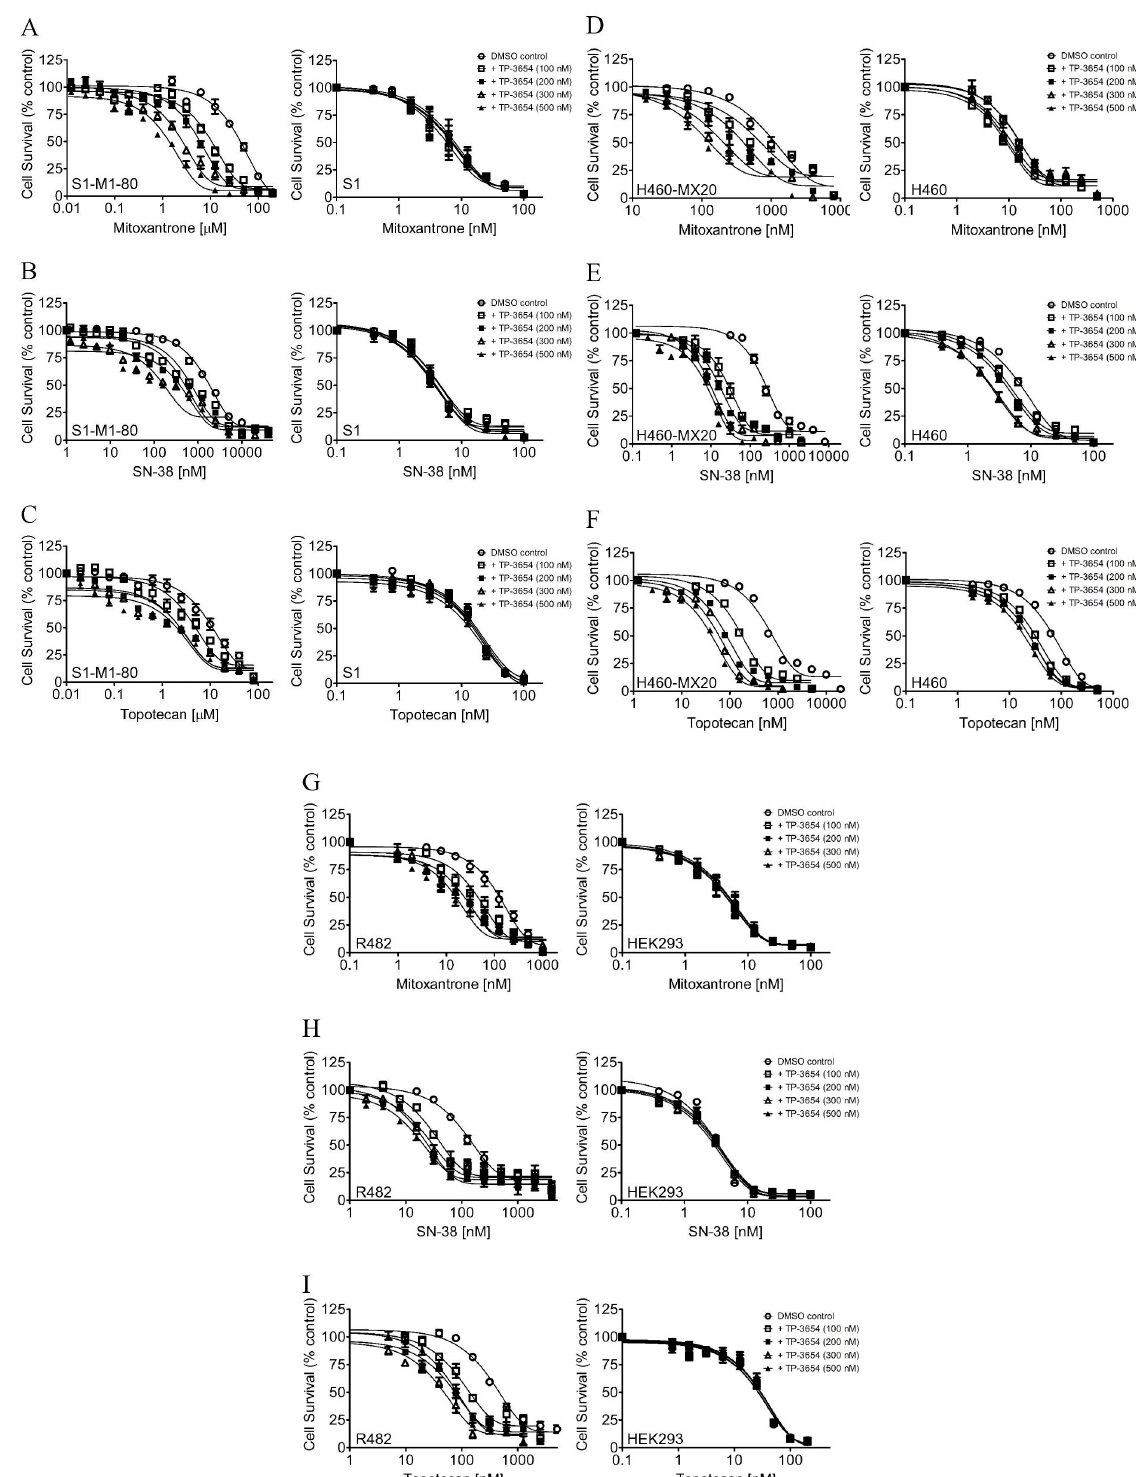
Figure 1. TP-3654 resensitizes ABCG2-overexpressing cancer cells to cytotoxic anticancer drugs. The cytotoxicity of mitoxantrone, SN-38, and topotecan was determined in ABCG2-overexpressing S1-M1-80 ( A – C , left panels) and drug- sensitive parental S1 ( A – C , right panels) cancer cells, ABCG2-overexpressing H460-MX20 ( D – F , left panels), and drug- sensitive H460 ( D – F , right panels) cancer cells, as well as ABCG2-transfected R482-HEK293 ( G – I , left panels) and parental HEK293 ( G – I , right panels) cells in the presence of DMSO (open circles) or TP-3654 at 100 nM (open squares), 200 nM (filled squares), 300 nM (open triangles), or 500 nM (filled triangles). Data represent means ± S.E.M. from at least three independent